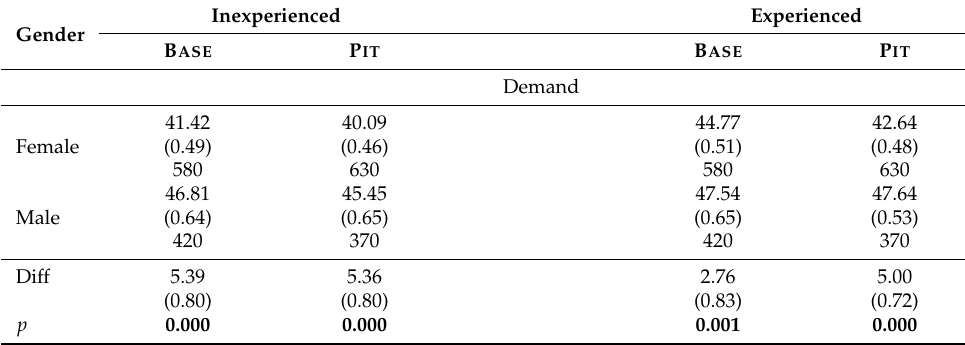
Table A5. Proposer Behavior by Experience, Treatment, and Gender.